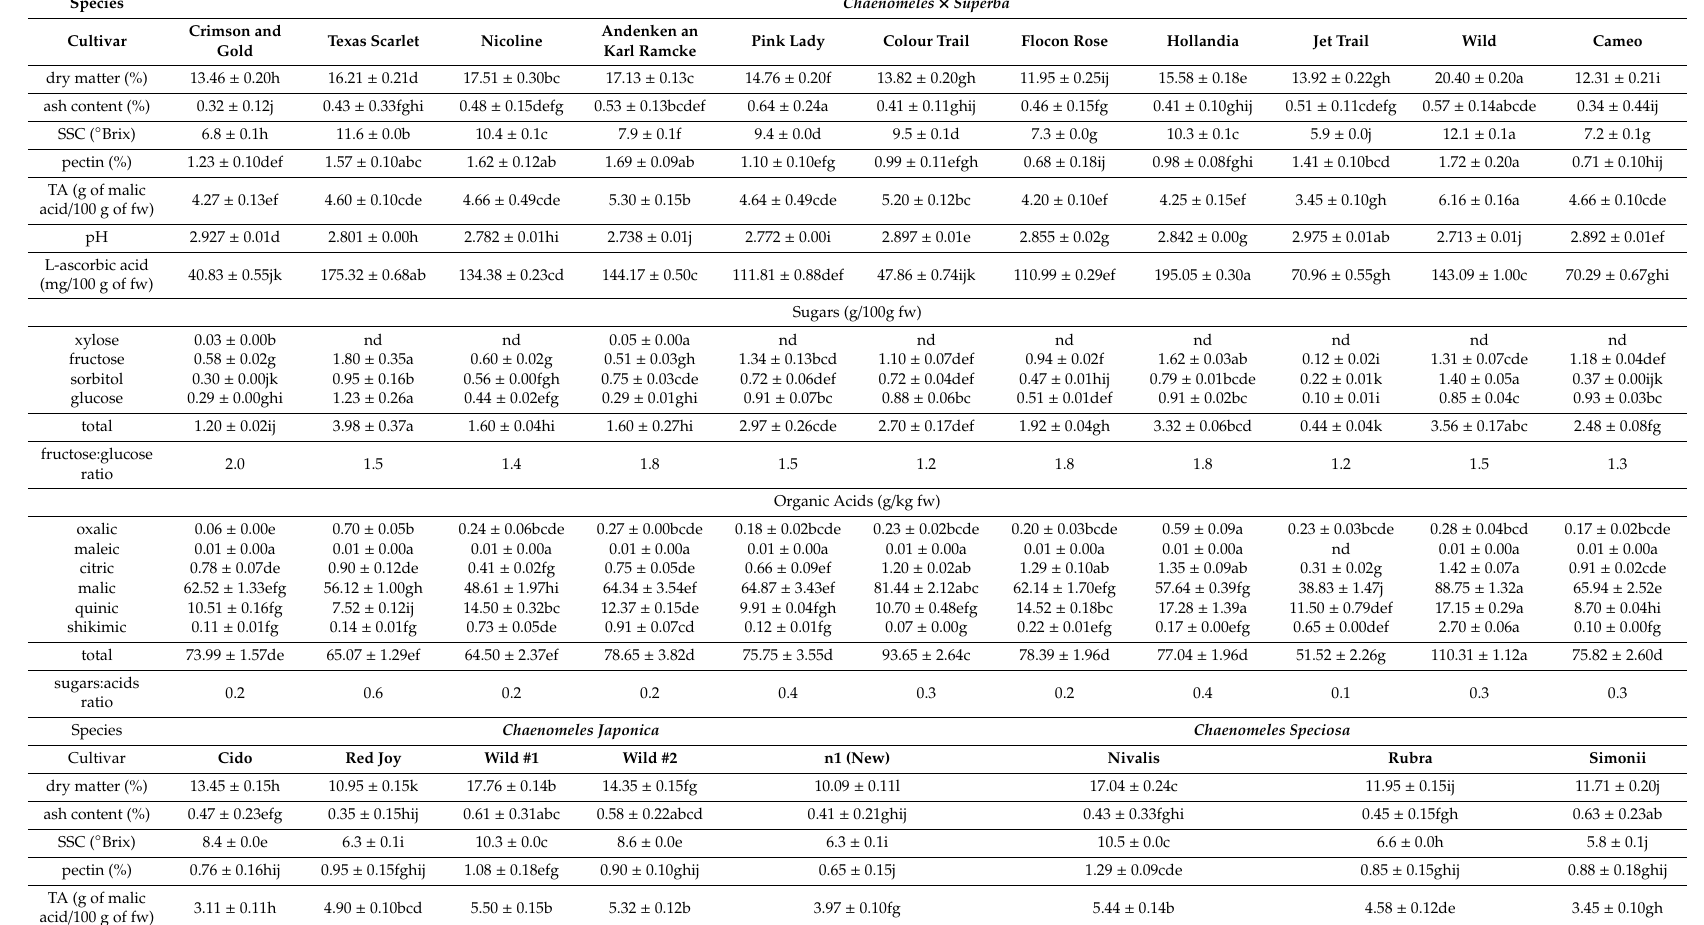
Table 1. Basic chemical composition of selected species and cvs. of Chaenomeles